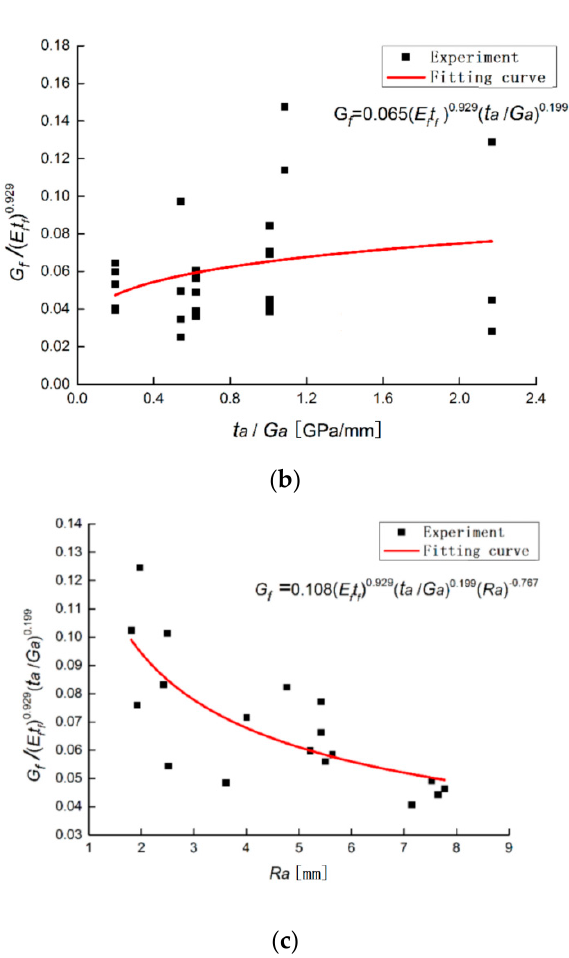
Figure 6. Influence of different factors on the interfacial fracture energy: ( a ) Testing group of the specimen with different CFRP fabric stiffnesses; ( b ) Testing group of the specimen with different glue thicknesses. ( c ) Testing group of the specimen with different surface roughnesses.